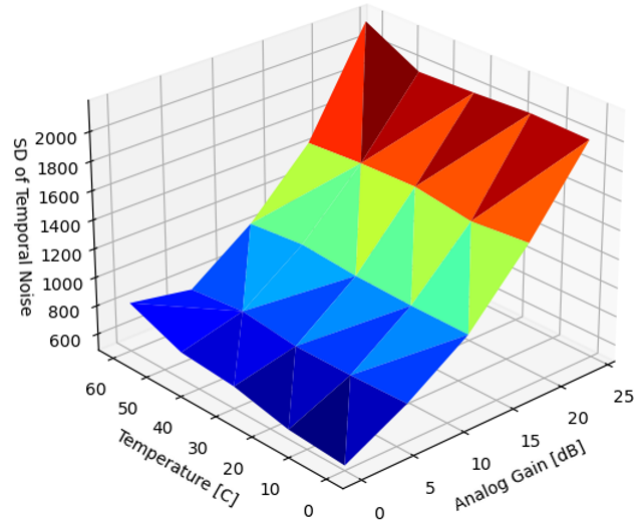
Figure 17. σ t ( α , T ) ◦ C, α = 0.0